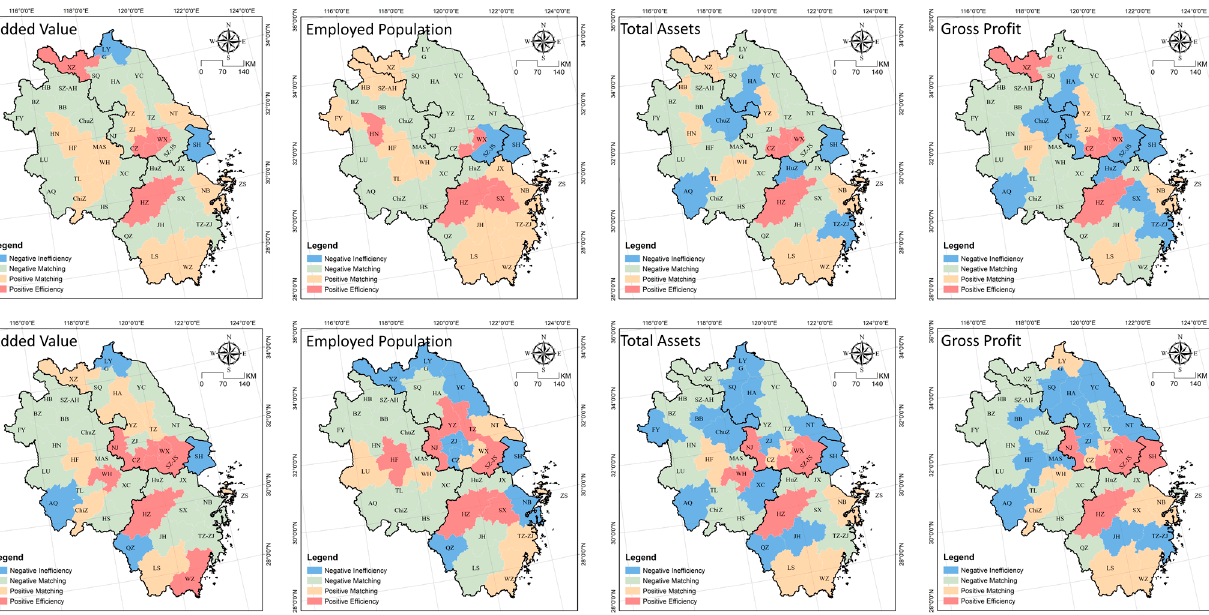
with average positive and negative spatial mismatch indexes of 0.61 and − 0.28, respectively. A total of 53.66% of the cities experienced negative matching and they were con- centrated in contiguous distribution in Anhui, Jiangsu, and central Zhejiang; and 24.39%